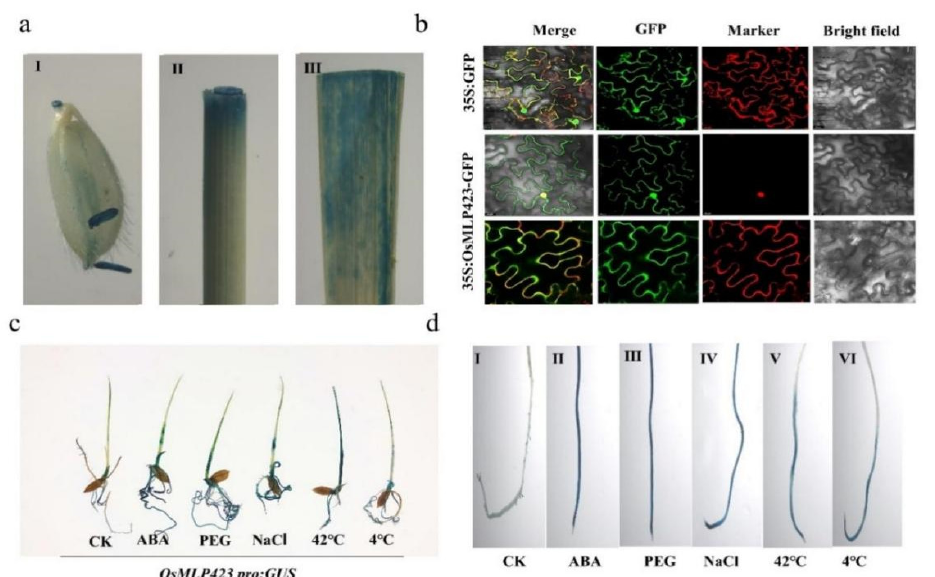
Figure 2. Expression pattern analysis of OsMLP423 . ( a ) OsMLP423pro: GUS transgenic plants showed staining of different tissues. (I: glumes; II: stems; III: mature leaf.) ( b ) Subcellular localiza- tion of OsMLP423 in tobacco. Scale bars are 20 mm. ( c ) GUS staining of OsMLP423pro :GUS trans- genic plants under different stress treatments. ( d ) Detection of GUS activity in roots of OsMLP423 promoter under abiotic stress. ( Ⅰ : CK; Ⅱ : ABA; Ⅲ : PEG-6000; Ⅳ : NaCl; Ⅴ : 42 °C; Ⅵ : 4 °C).